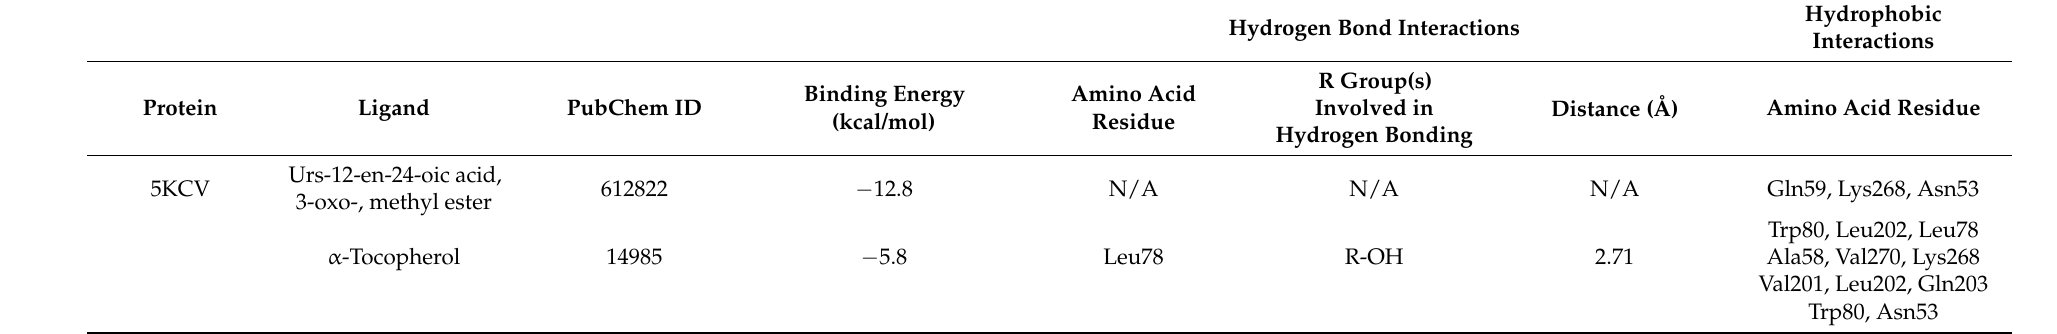
Table 6. Binding energy of potential bioactives on Akt1 (PDB ID: 5KCV).